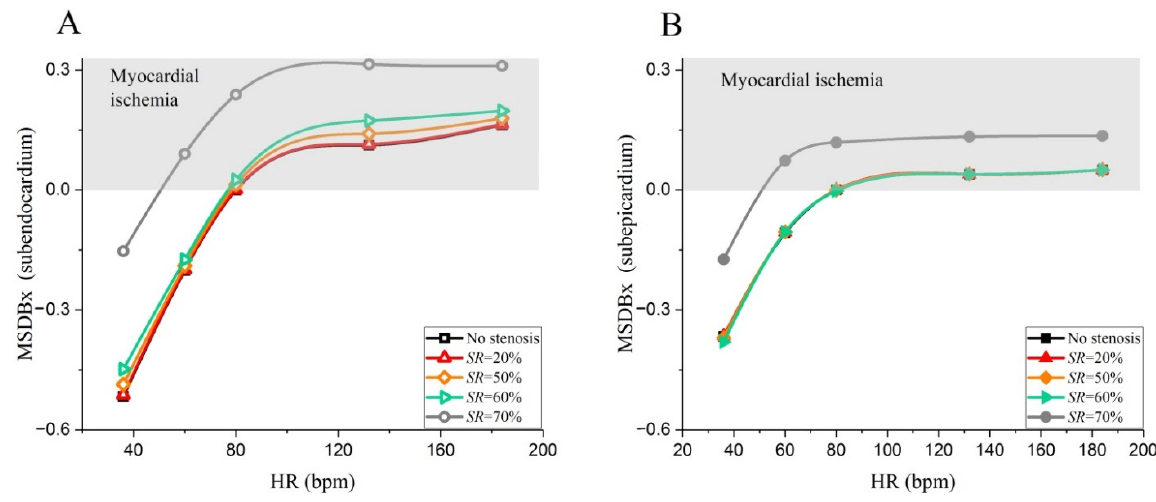
Figure 5. Relationships between MSDBx and HR in the subendocardium ( A ) and subepicardium ( B ) in the absence or in the presence of coronary artery stenosis of various severities ( SR = 20~70%).